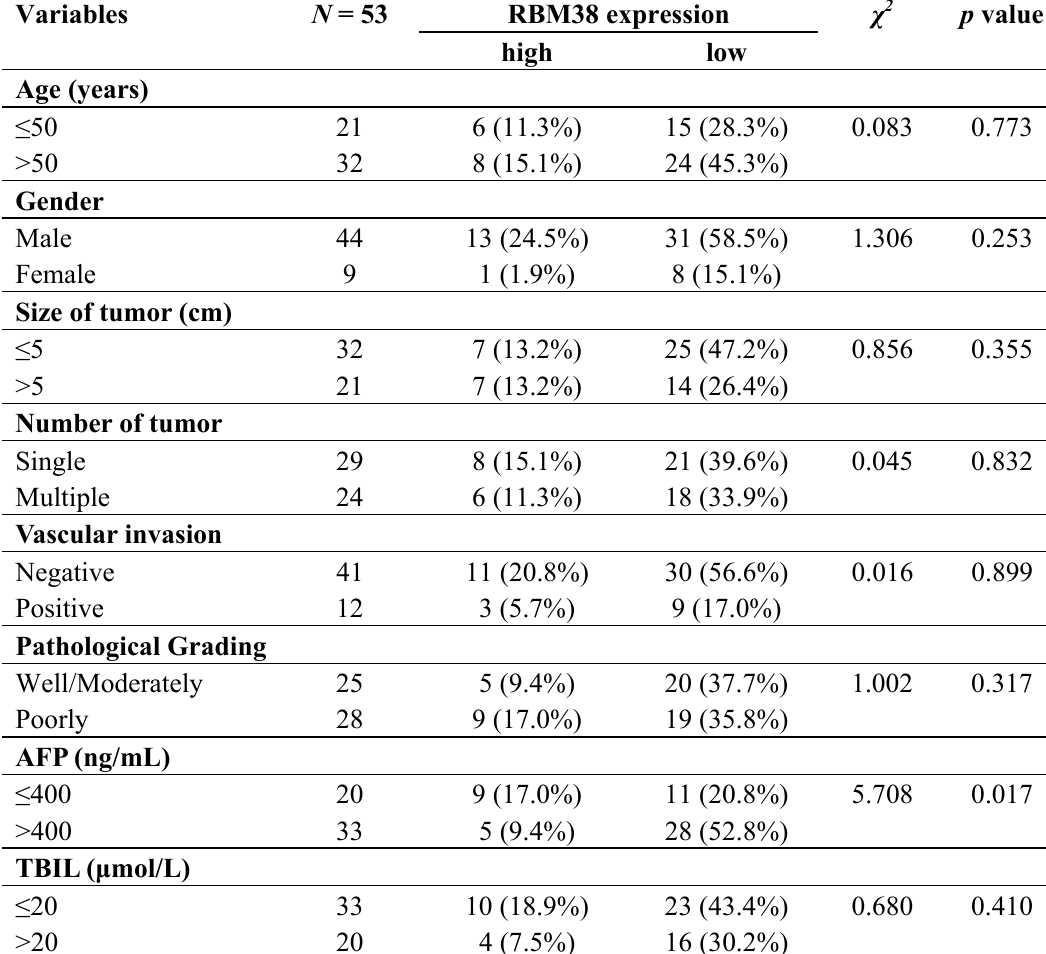
Table 1. Relationship between RBM38 expression and clinicopathological features of 53 hepatocellular carcinoma (HCC)